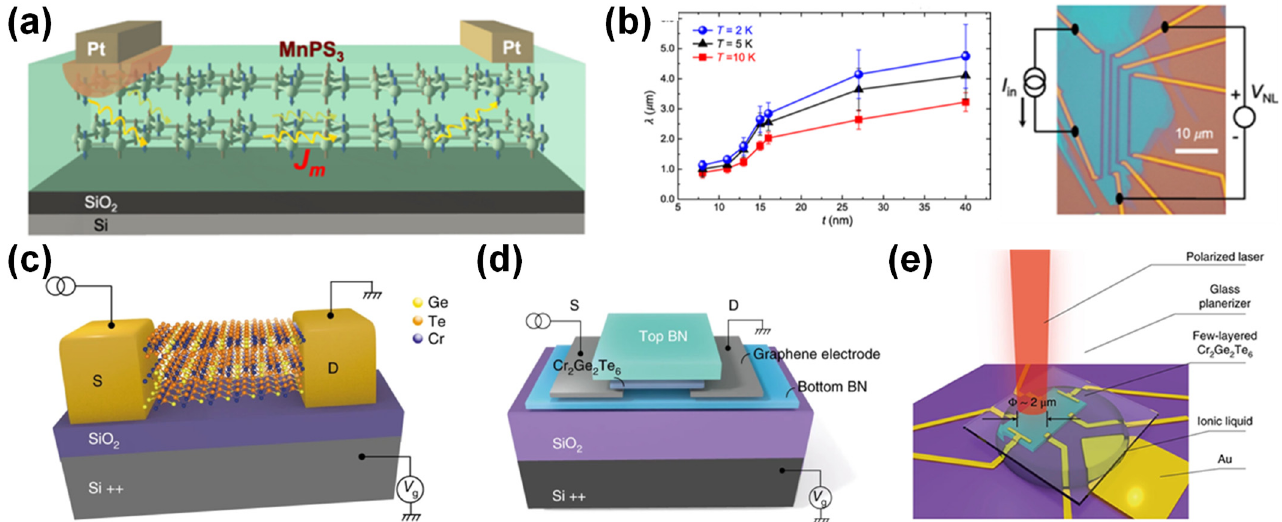
Figure 9. ( a ) Scheme of nonlocal measurements made of an MnPS 3 device. Reused with permission from [163]. ( b ) Scheme of long-distance magnon transport of MnPS 3 (right panel), and magnon relaxation distance as a function of crystal thickness in quasi-2D MnPS 3 at 2, 5, and 10 K (left panel). Reused with permission from [163]. Schematics of ( c ) an Au-contacted, few-layered Cr 2 Ge 2 Te 6 device and ( d ) a few-layered Cr 2 Ge 2 Te 6 flake encapsulated by two h-BN layers, contacted via graphene electrodes. ( e ) Experimental setup for Kerr measurement of the micrometer-sized device using an ionic liquid. Reused with permission from [61] .